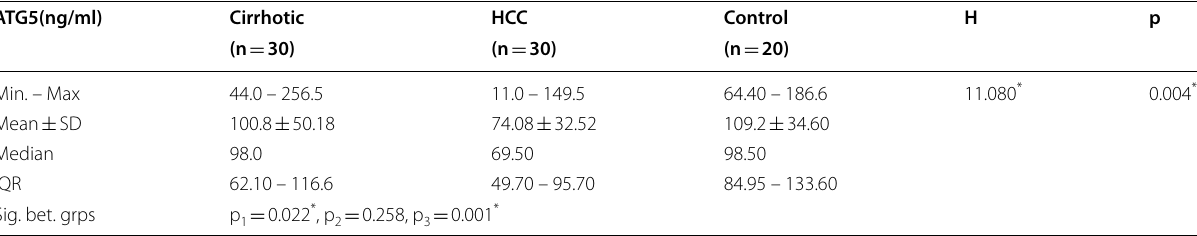
Table 5 Comparison between the three studied groups according to ATG5